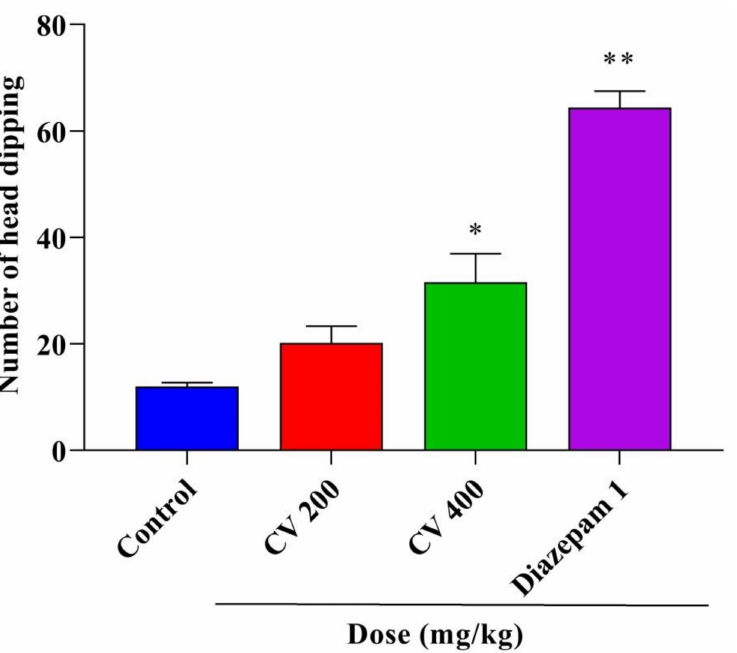
Figure 3. Anxiolytic activities of the methanol extract of Cnesmone javanica (CV) and diazepam as assessed by the hole-board test. Significant differences (* p < 0.01 and ** p < 0.001) were assessed using one-way analysis of variance (ANOVA, followed by Dunnett’s